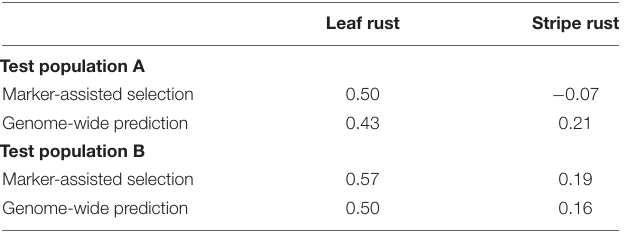
TABLE 4 | Prediction ability implementing marker-assisted in comparison to genome-wide selection on different trainings and test populations to predict leaf rust and stripe rust resistance based on all available marker information in contrast to significant marker data out of association mapping. Leaf rust Stripe rust